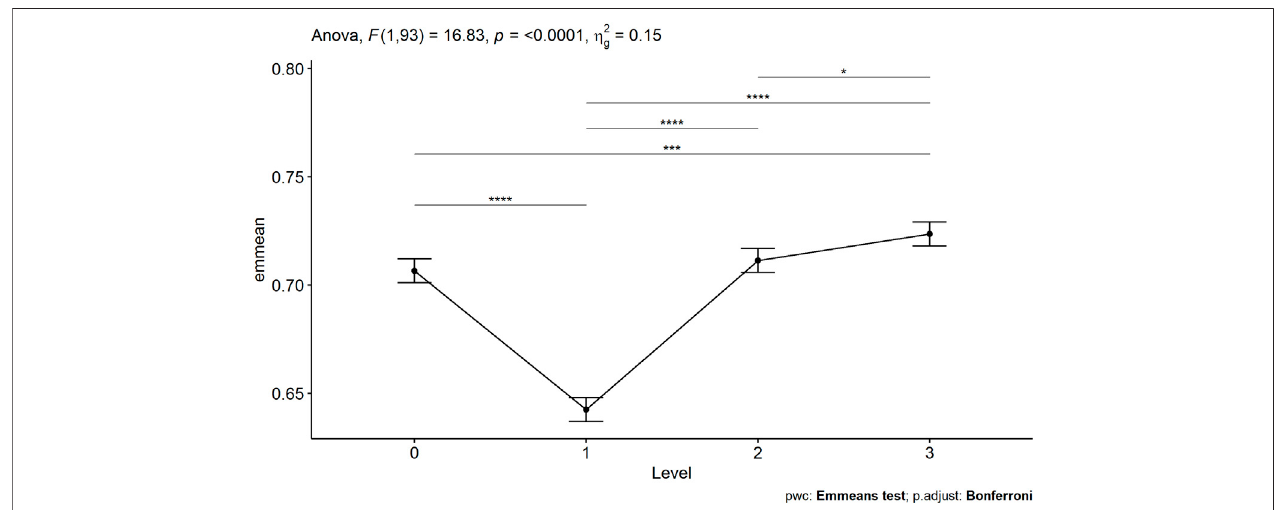
FIGURE 4| NDVI values over time recorded for a total of 375random points equally distributed among the four levels ofprotection and four dominant tree species ( Nothofagus dombeyi , N. antarctica , N. pumilio , and Austrocedrus chilensis ).